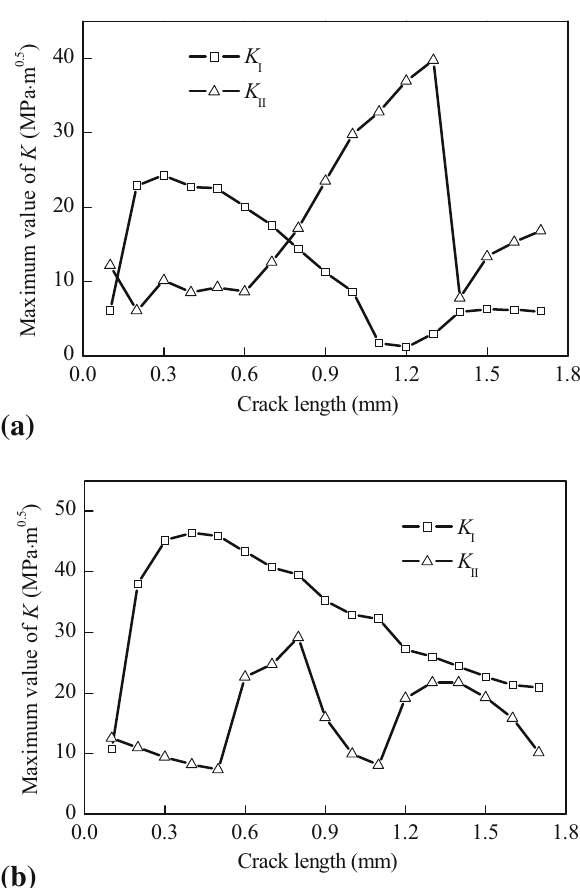
Fig. 5 Variation of K eff with the crack length